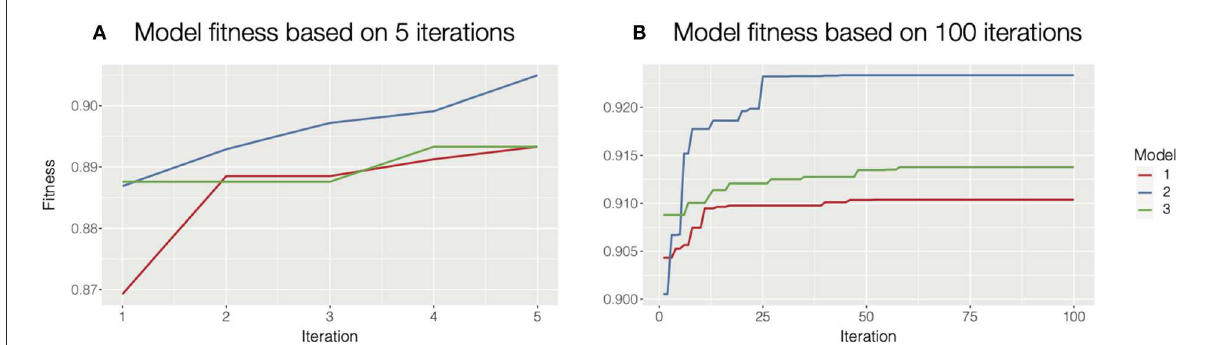
FIGURE2 Diagnosing model fitness with plot_fitness function. In this case, we used three different model constraints, hence we computed three models. (A) For illustrative purposes we ran autohrf for only 5 iterations with a population of 10. It is clear that the solutions at the end did not converge as the fitness is still rising. In such cases, we should increase the number of iterations or the population size and repeat the process. We could also rerun autohrf and set its autohrf parameter to the outputs of the previous run, which will continue the automated parameter search by using the results of the previous run. (B) In this case, we ran autohrf with the same model constraints, but this time we used the default settings (100 iterations with a population size of 100). It is clear that the solutions here converged as the optimal solution did not change for any of our constraints in the last 40